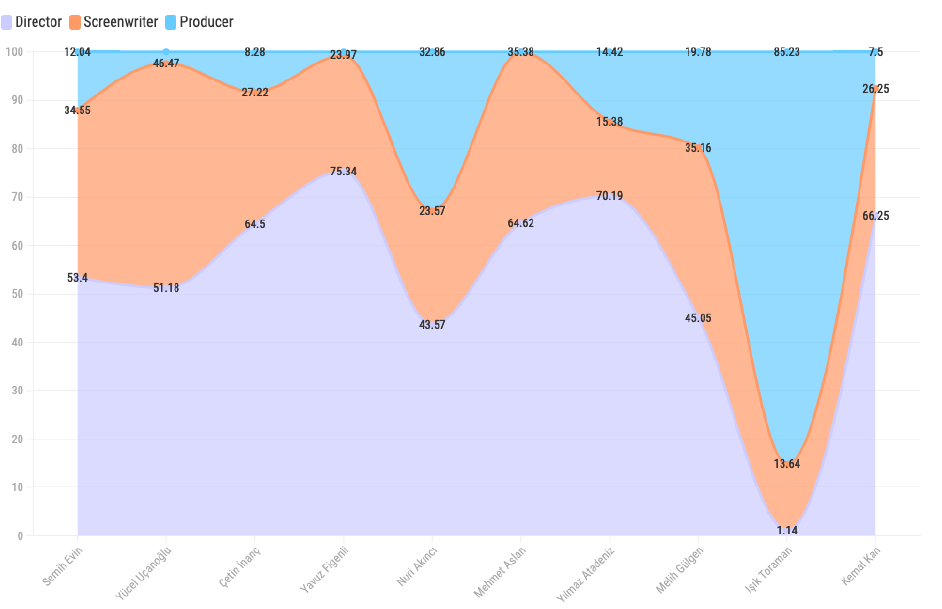
Figure 4. Percent stacked area charts showing the most prominent players and their professions based on weighted degree (1960-1979). B